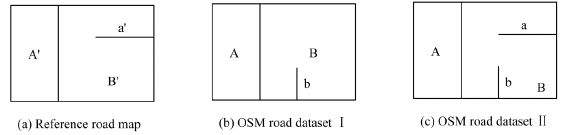
Figure 2. A series of schematic road networks to explain how to determine the completeness of a street block